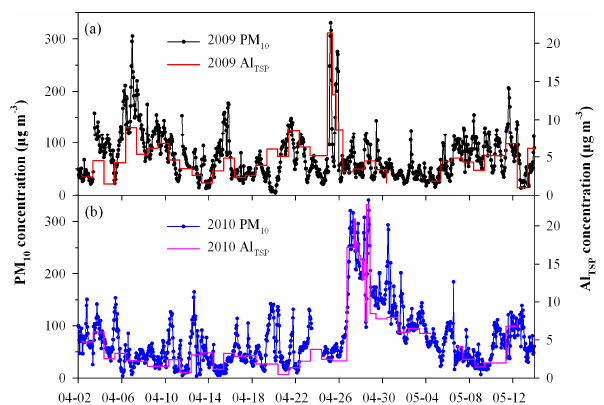
Figure 3. Time-series of hourly PM 10 concentrations and daily Al concentrations in TSP (Al TSP ) during the spring study period from April 2 to May 12 in 2009 (a) and 2010 (b), respectively. Fig. 3. Time series of hourly PM 10 concentrations and daily Al con- centrations in TSP (Al TSP ) during the spring study period from 2 April to 12 May in 2009 (a) and 2010 (b) ,